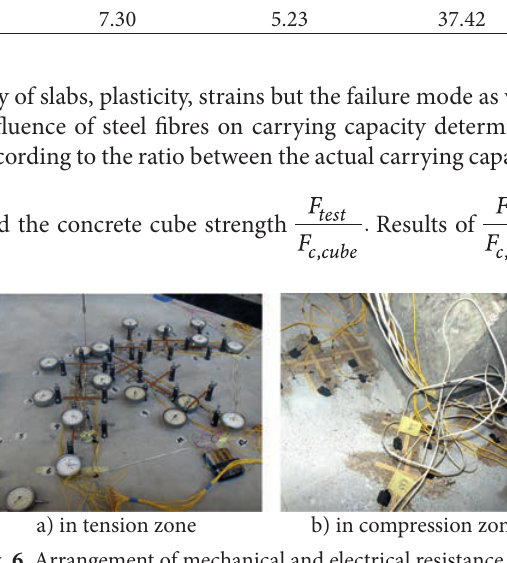
Fig. 6. Arrangement of mechanical and electrical resistance strain